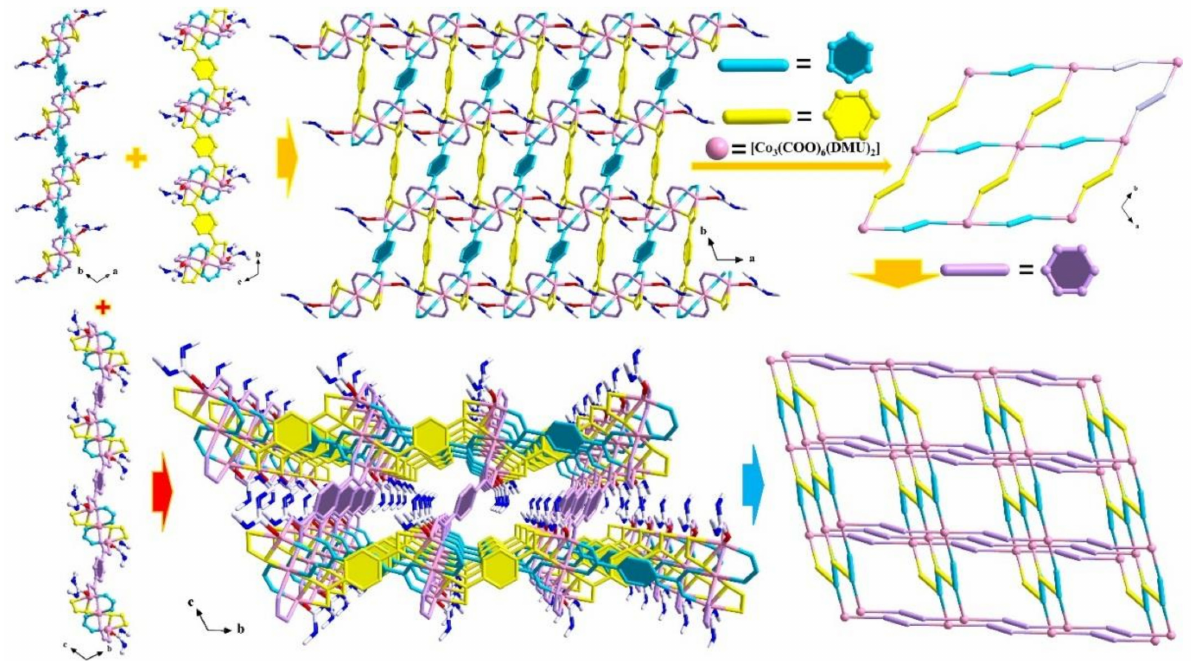
Figure 1. The structure construction of